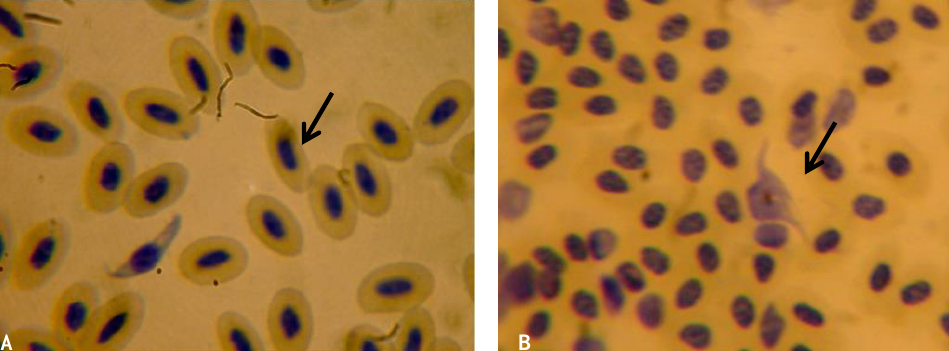
Figure 2; A and B: Chickens blood smears showing Haemoproteusspp. gametocytes